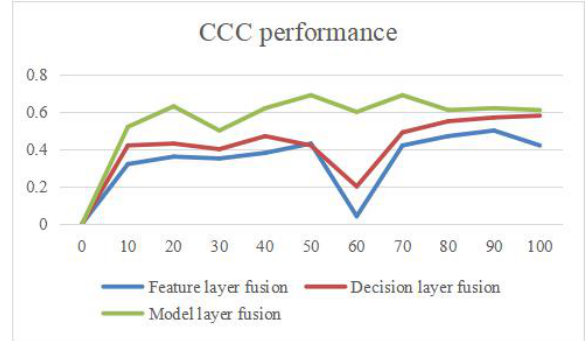
Fig. 6. Visualization of epochs and CCC of three fusion